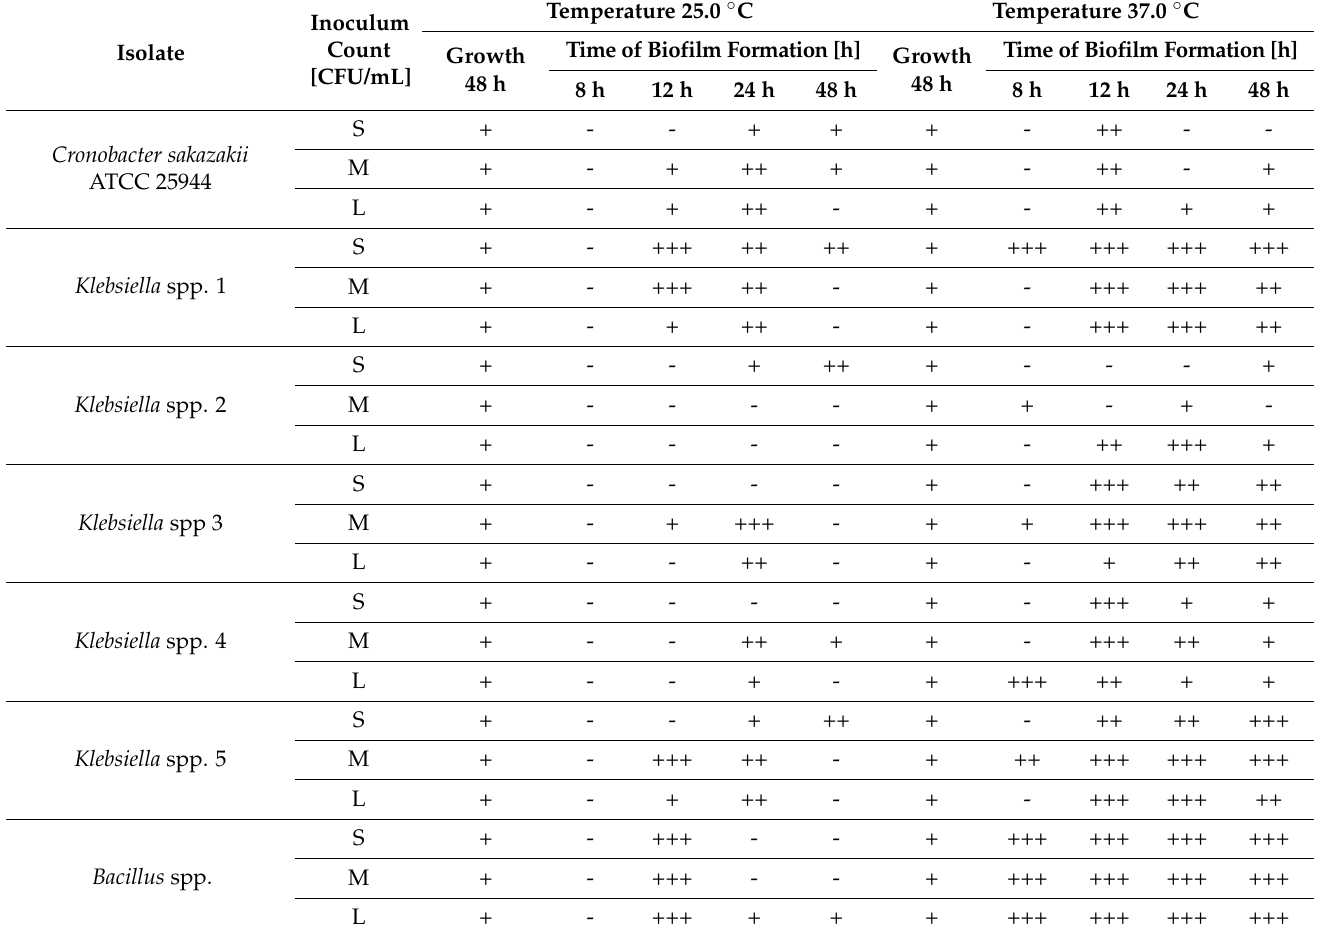
Table 1. Biofilm formation on the hydrophobic surface as a result of various combinations of inoculum size, time, and incubation